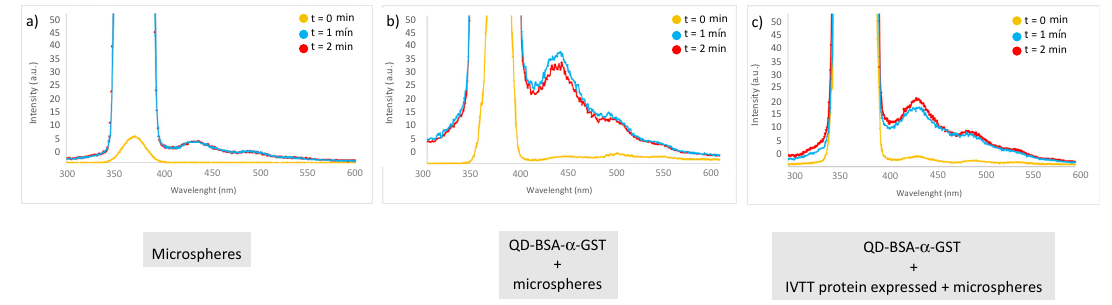
Figure 12. Fluorescence emission spectra at λ ex = 370 nm, ( a ) microspheres ( b ) QDs-BSA- α -GST and microspheres, ( c ) QDs-BSA- α -GST with expression of p53 and microspheres. First spectrum represents the behavior of the microspheres as a negative control (Figure